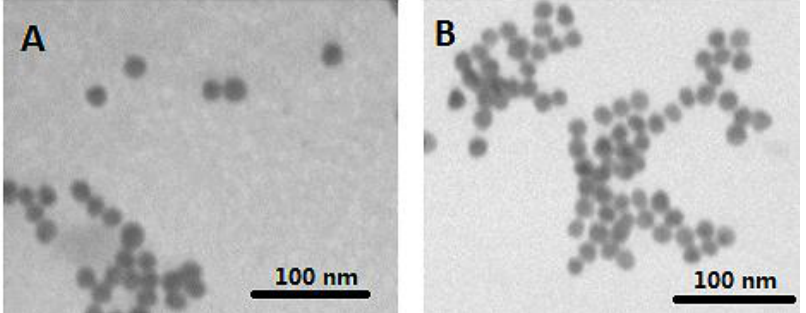
Figure 1. TEM images of citrate capped AuNPs ( A ) and cODN capped AuNPs ( B